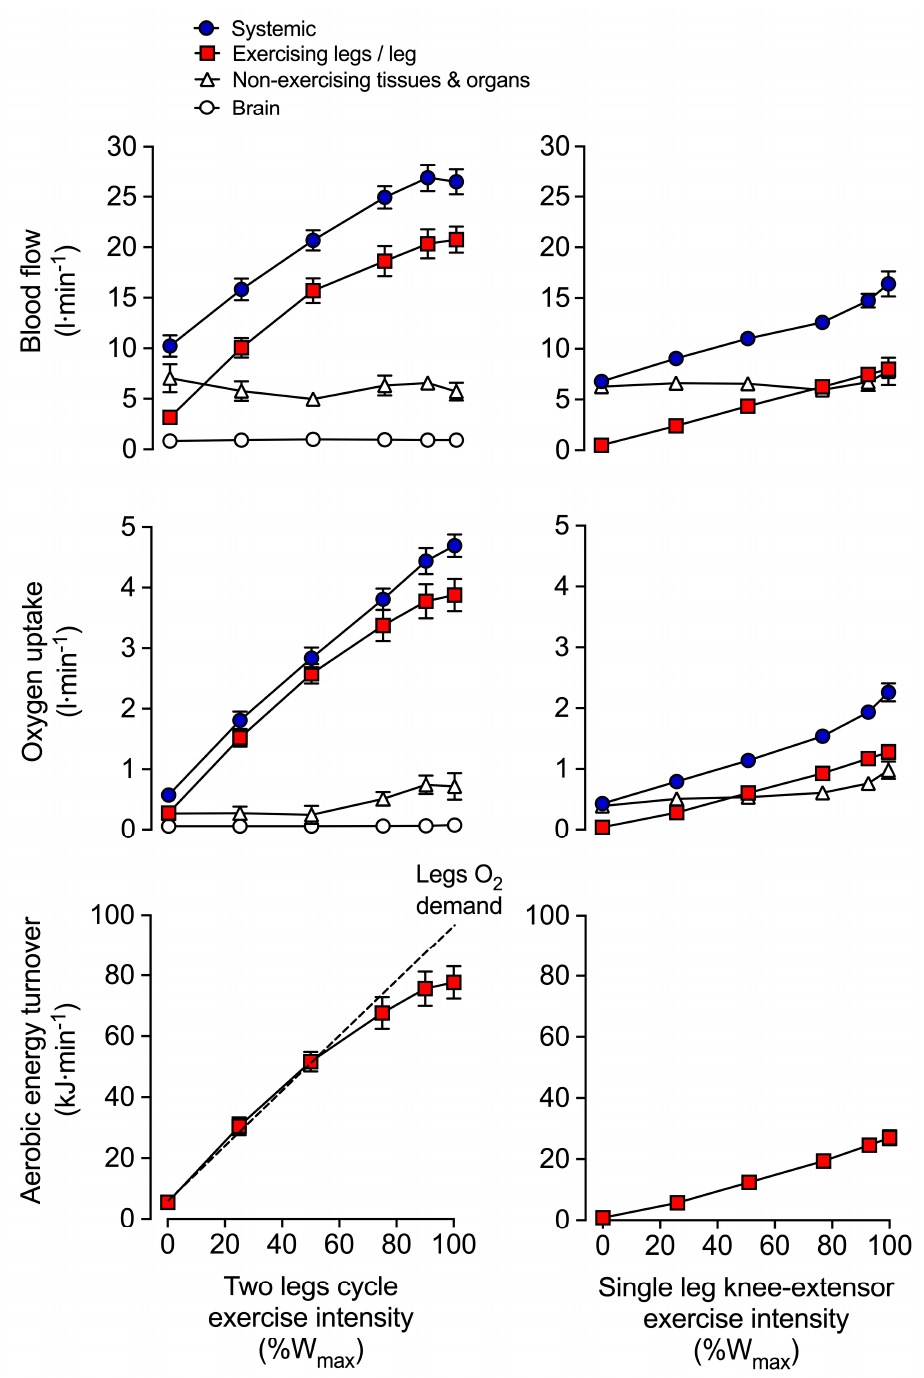
Figure 1. Blood flow, oxygen uptake and energy turnover during exhaustive incremental two-legged cycle exercise and single leg knee-extensor exercise. These data demonstrate that the rate of rise in exercising muscle blood flow, oxygen uptake ( V O 2 ) and aerobic energy turnover is blunted during heavy-to-severe intensity cycle exercise but not during exhaustive single leg knee-extensor exercise. The dotted line indicates the theoretical two legs O 2 demand, assuming a linear relationship between exercise intensity and V O 2 across all cycle exercise intensities, as found during single leg knee-extensor exercise. Limited data suggest that brain V O 2 is preserved (via increases in O 2 and substrate extraction from the circulation) in the face of reduced brain blood flow and O 2 supply during maximal aerobic exercise. Redrawn from data (means ± SE) reported by Mortensen et al. [64], Trangmar et al. [36], Sato et al. [34], and Gonz á lez-Alonso et al.